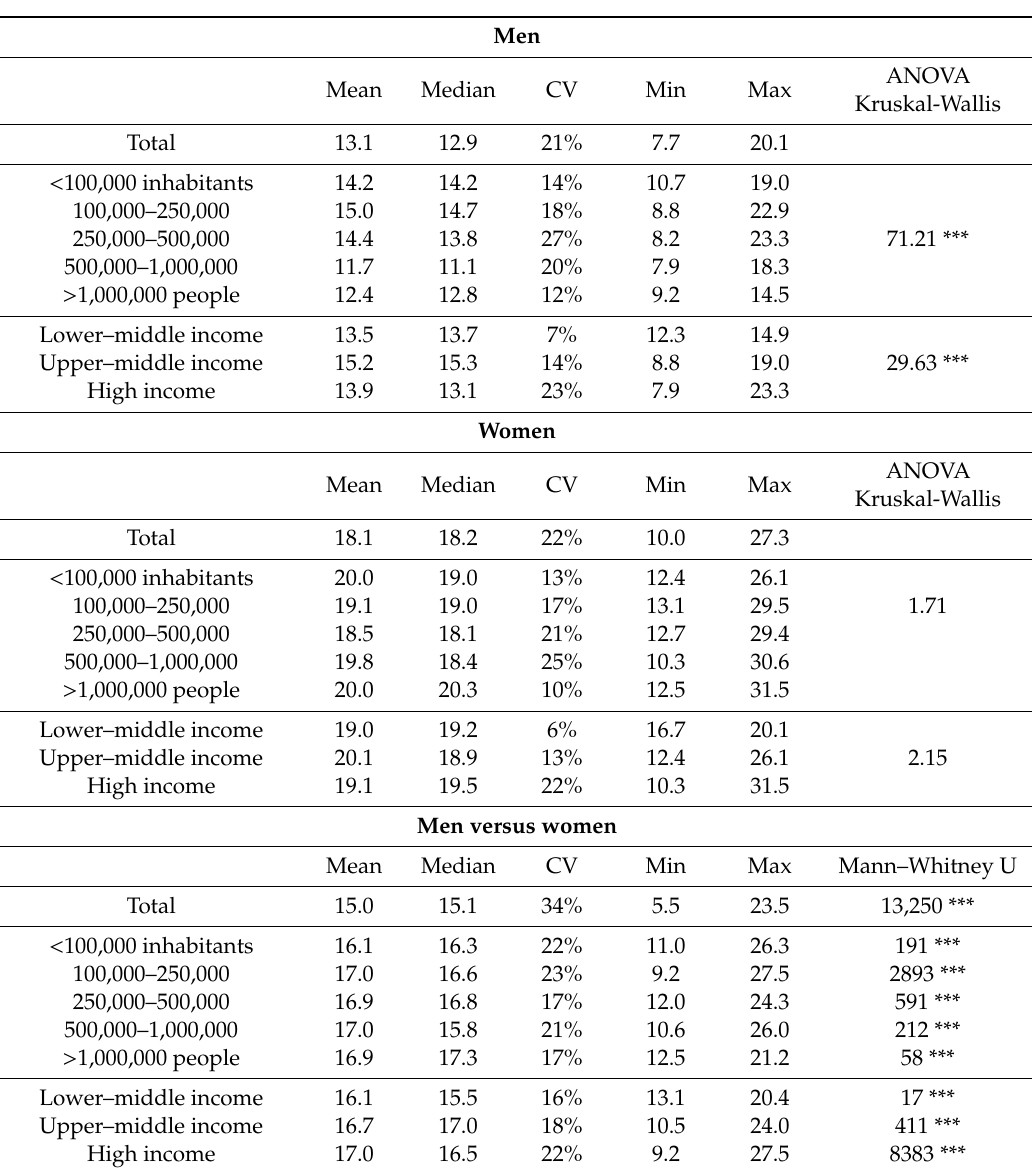
Table 1. Statistics of the population of older people (aged 65 or above) data by gender, size of city and level of economic development (average over years